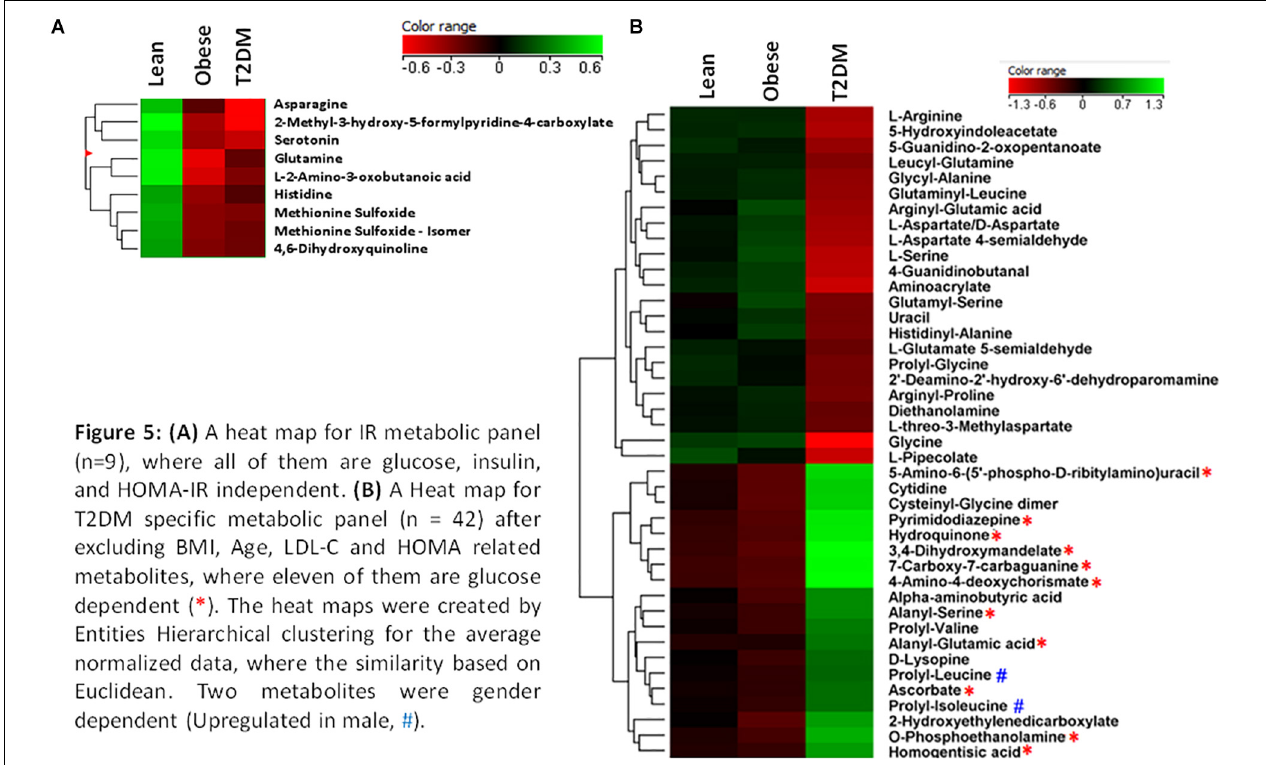
FIGURE 5 | (A) A heat map for IR metabolic panel ( n = 9), where all of them are glucose, insulin, and HOMA-IR independent. (B) A heat map for T2DM specific metabolic panel ( n = 42) after excluding BMI, age, LDL-C, and HOMA related metabolites, where 11 of them are glucose dependent (*). The heat maps were created by entities hierarchical clustering for the average normalized data, where the similarity based on Euclidean. Two metabolites were gender dependent (up-regulated in male,